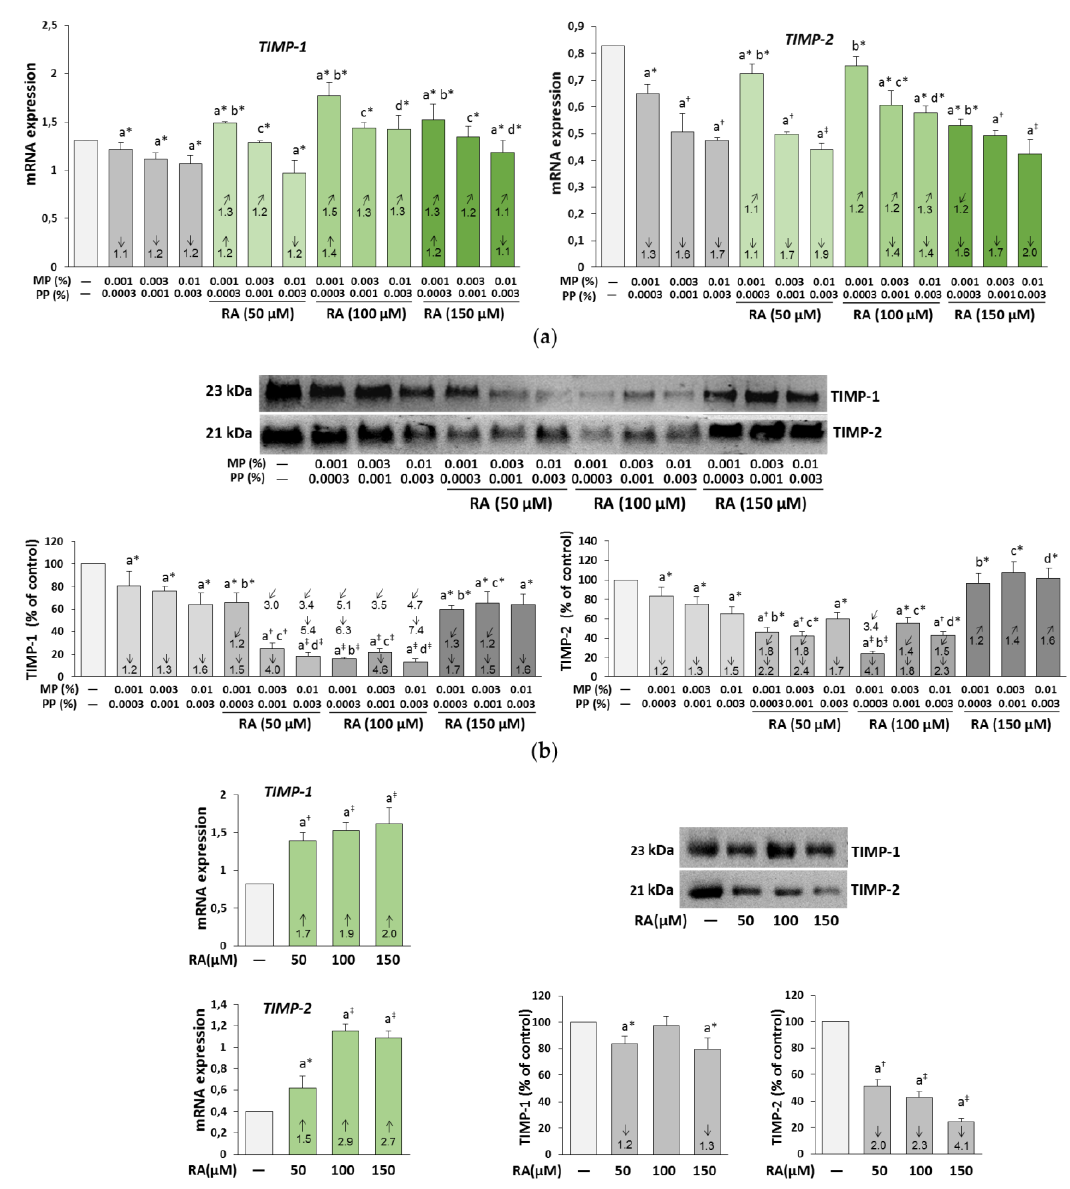
Figure 10. The influence of rosmarinic acid (RA) on the expression of tissue inhibitors of matrix metalloproteinases (TIMP-1 and TIMP-2) at mRNA ( a , c ) and protein ( b , d ) levels in the fibroblasts treated with methylparaben (MP) and n-propylparaben (PP) ( a , b ), and untreated cells ( c , d ). Expression of genes was assayed by real-time PCR, values represent the mean ± SD of three experiments done in duplicate ( a ), ( c ). Representative gels of Western blotting ( b , d ), the intensity of the bands was quantified by densitometry, values represent the mean (% of control) ± SD of three experiments. Statistically significant differences are marked as: a vs. control, b vs. 0.001% MP and 0.0003% PP, c vs. 0.003% MP and 0.001% PP, d vs. 0.01% MP and 0.003% PP; * p < 0.05; † p < 0.01; ‡ p < 0.001. The values in the bars show a factor of change in comparison to the control ( ↑ , increase; ↓ , decrease) or to the respective samples treated with parabens alone (MP and PP) ( ↗ , increase; ↙ , decrease).